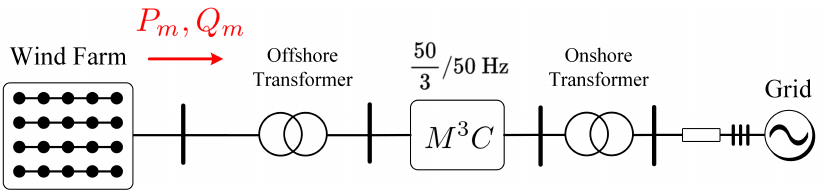
Figure 18. LFAC transmission system for offshore wind farms. Based on [79].